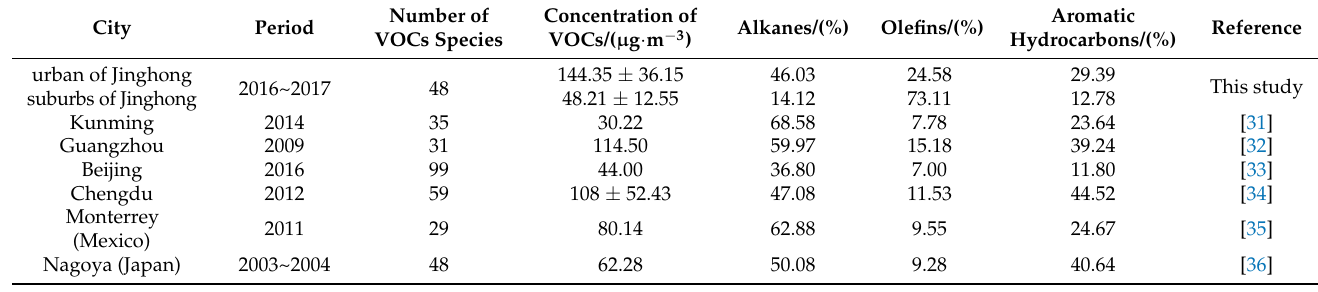
Table 1. Concentration levels of atmospheric VOCs in different cities.